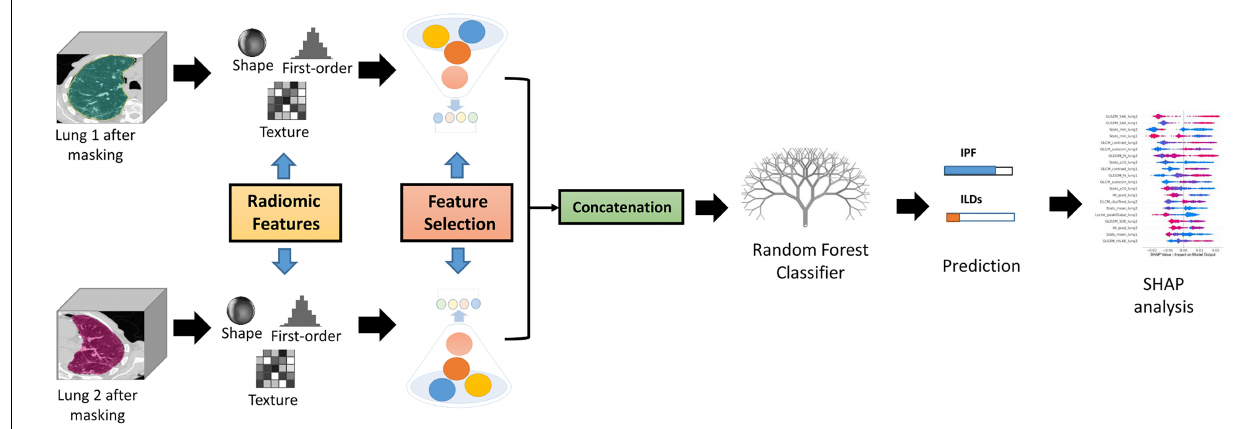
FIGURE 2 | Radiomics Pipeline for Lung disease classification from CT images. The same 12 radiomics features from both lungs after feature selection are concatenated and fed to the Random Forest classifier. Post-hoc SHAP analysis is performed for